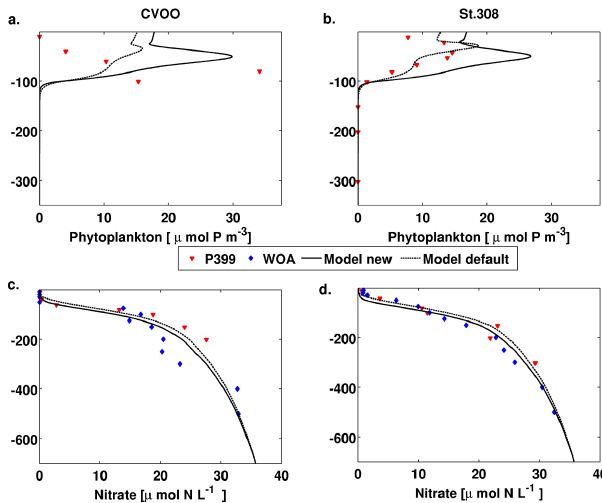
Fig. A3. Phytoplankton (a, b) and nutrient (c, d) concentrations in April (a, c) and June (b, d) [µmolPm − 3 ] – model-predicted (black solid lines new and dashed lines default parameter setup) and ob- served (red markers) profiles. Observations were taken from the Po- seidon cruise P399/2 in 2010. Phytoplankton concentrations have been derived from chlorophyll, using a vertically dependent C:Chl ratio (e.g. Hense and Beckmann, 2008) and the Redfield ratio for conversion from carbon to